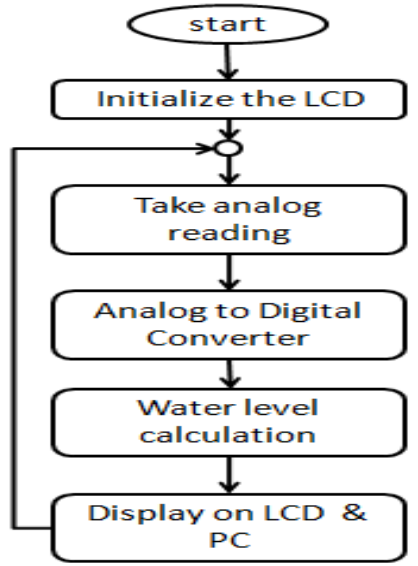
Figure 9: Programming flowchart.